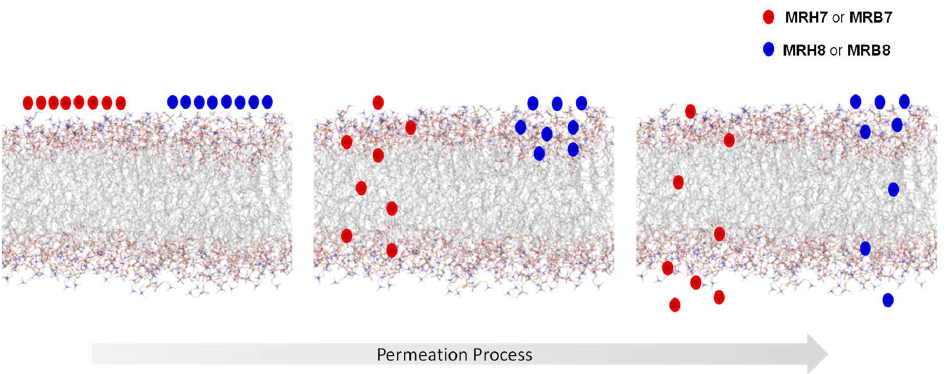
Figure 7. Scheme of a assumed mode of interaction and progress of the rhodamine labelled 3,4-HPO chelators, MRH7 and MRB7 (red) and MRH8 and MRB8 (blue) through the biological membranes, along the permeation